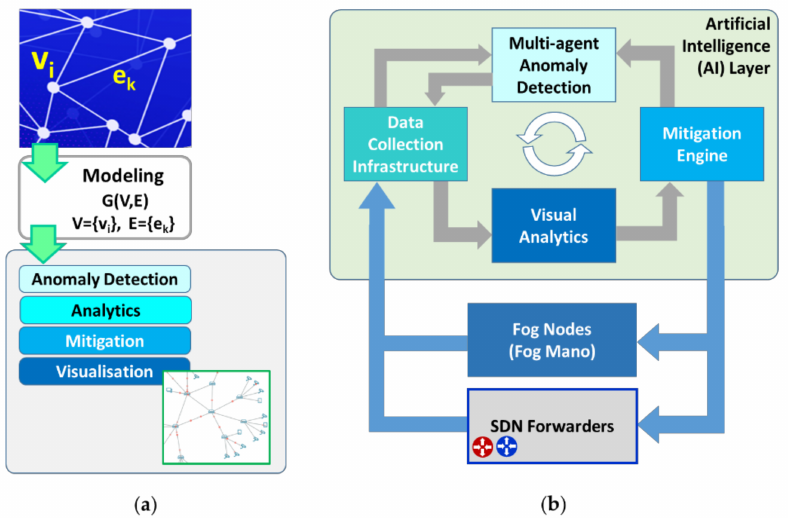
Figure 3. ( a ) Modelling of the IoT network as a graph G( V , E ) that enables the application of computational processes for anomaly detection, analytics, mitigation and visualization; ( b ) workflow between the components of the artificial intelligence layer, the fog substrate and the communication substrate